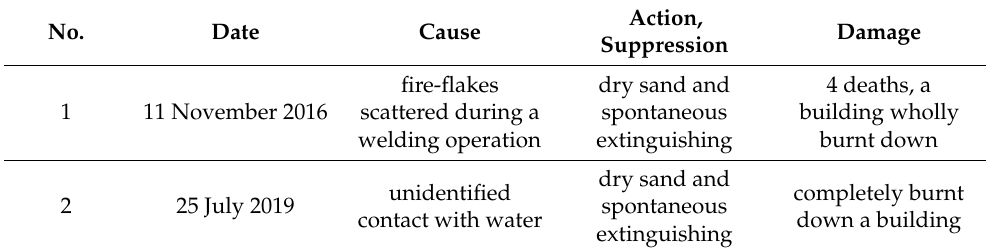
Table 2. Cases of magnesium fire and